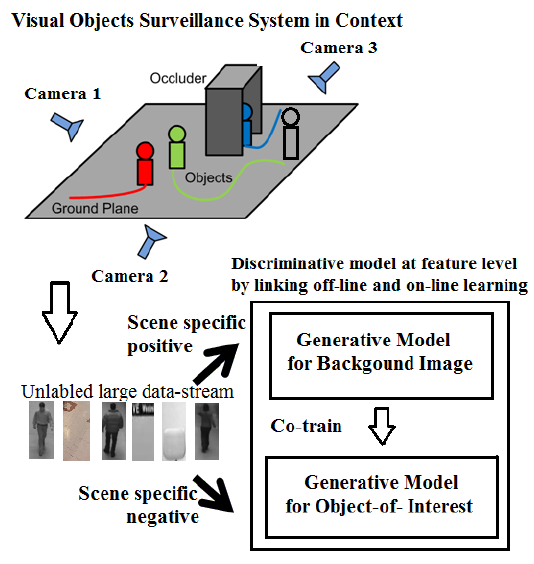
Figure 1. Combination of two generative models in one discriminative model at feature level by linking off-line and on-line learning in